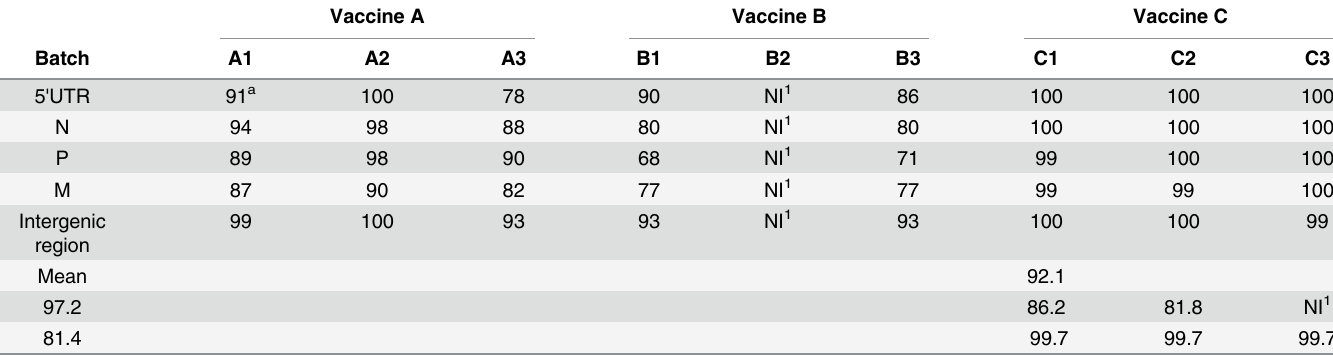
Table 3. Analysis of the eight vaccine batches using whole genome sequencing with the Illumina MiSeq 2000 platform. Vaccine